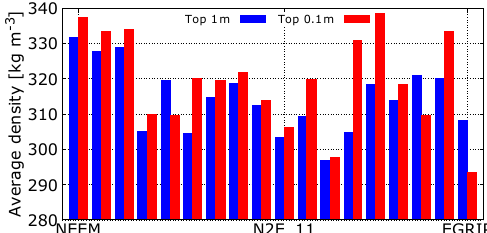
Figure 9. Average densities along the traverse through North Green- land (May 2015) in the top 1 and 0.1m derived from CT data.